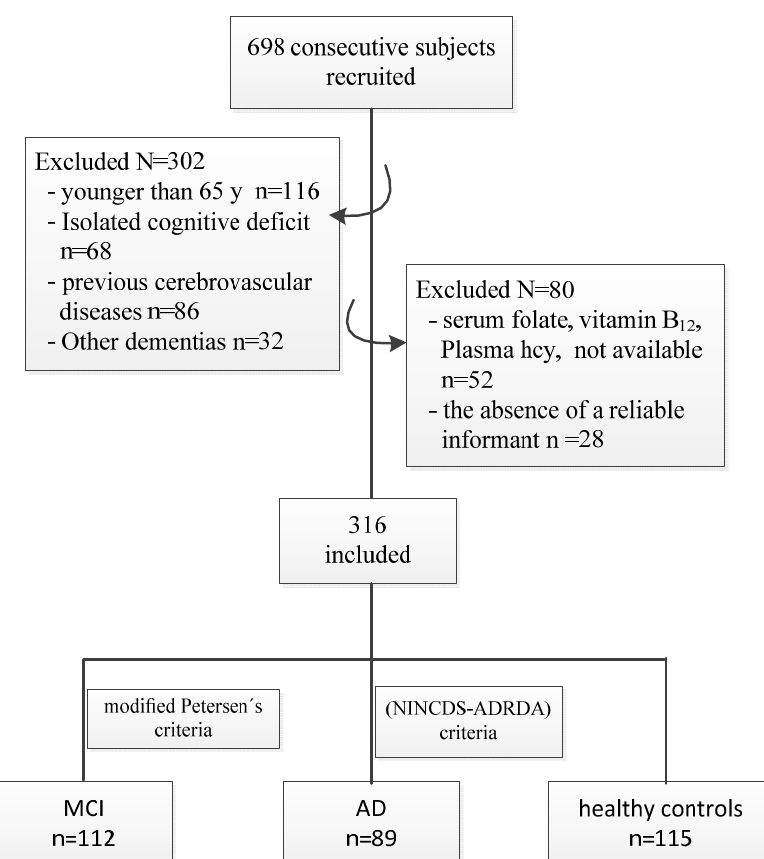
Figure 1. Flow chart detailing the derivation of the study